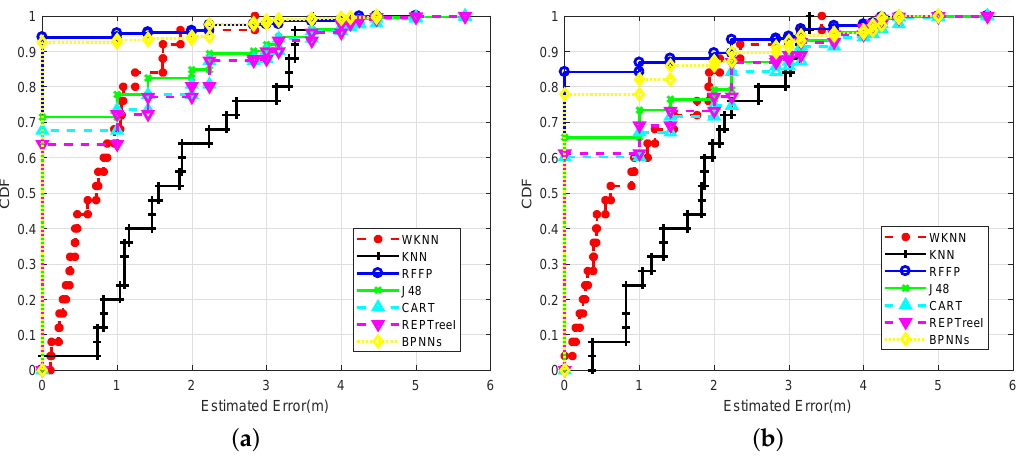
Figure 9. ( a ) CDFs of localization errors with different algorithms in LOS scenarios. ( b ) CDFs of localization errors with different algorithms in NLOS